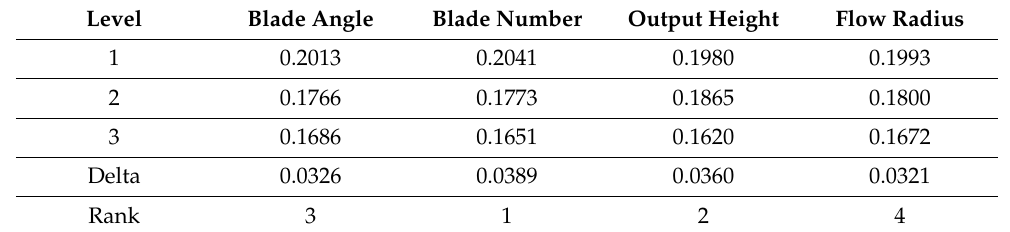
Table 9. Lower flow rate analysis of means.